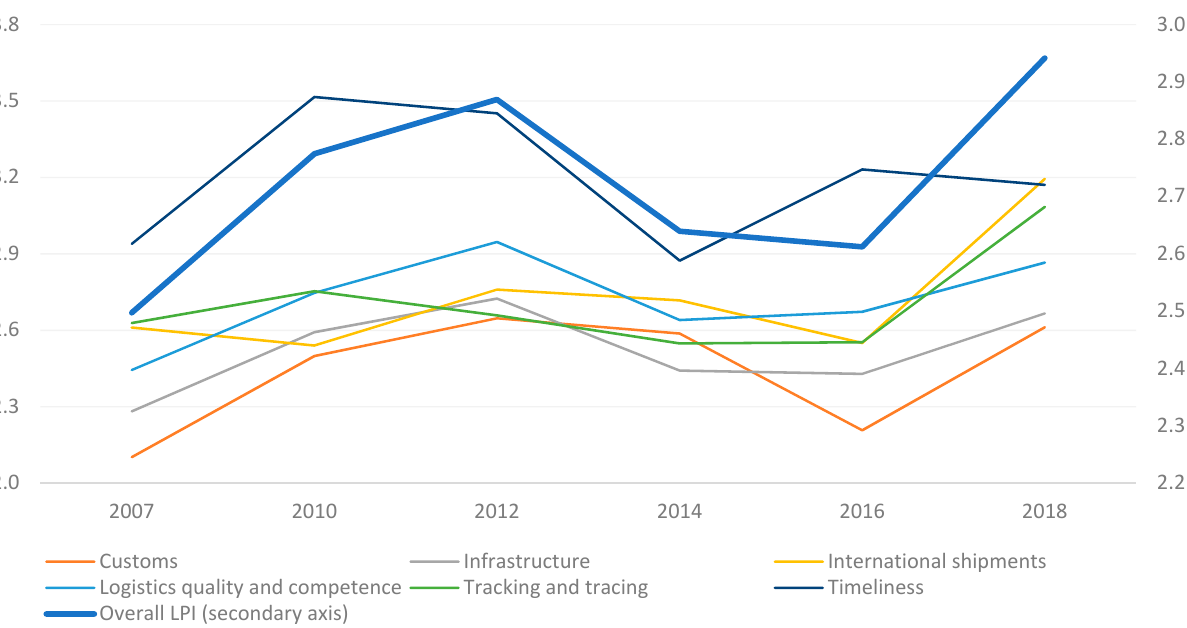
Figure 3. Index of logistics performance (from 1 = Low to 5 = High). Source: Logistics Performance Index, World Bank.